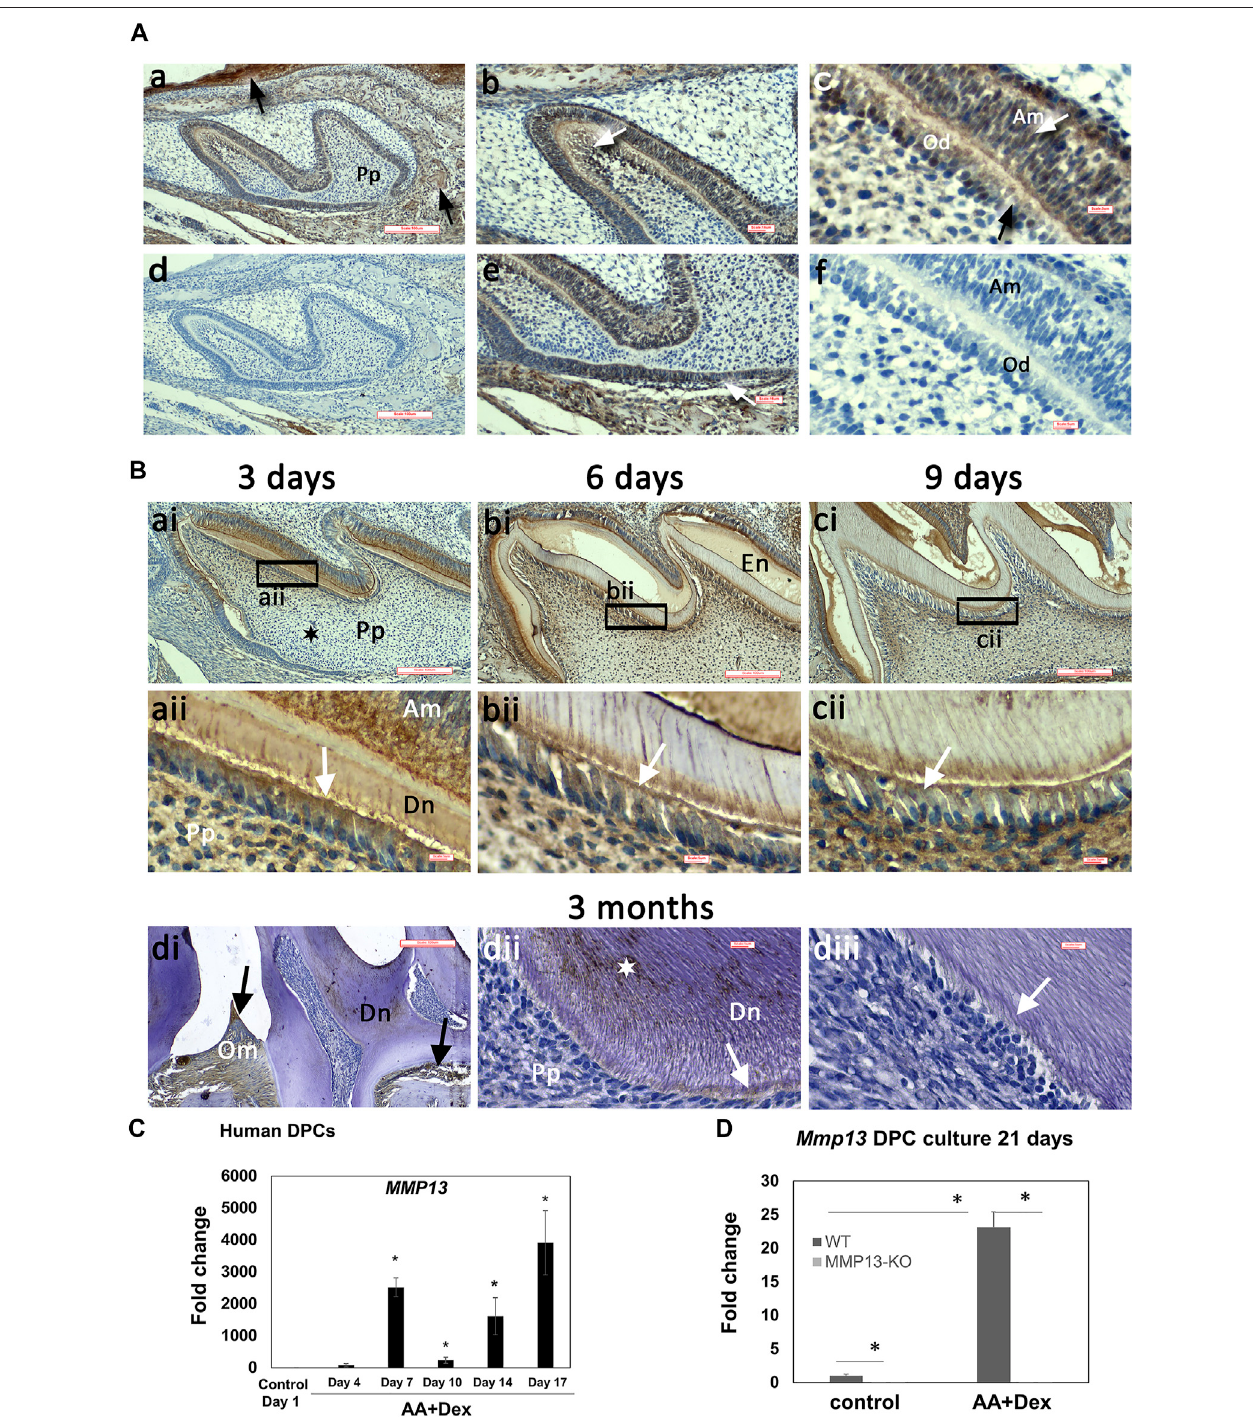
FIGURE 1 | High MMP13-expression in the dentin – pulp complex of developing mouse molars and in mineralizing human-DPC cultures. IHC analysisof MMP13 in sagittal tooth sections ofmaxillary fi rst molars (postnatal 1, 3, 6, 9-day, and 3-month). (A) Postnatal 1-d (a, b, c, e) and unstained controls (d, f) . MMP13 in oral mucosa and alveolar bone is highlighted in ( a — black arrows), in odontoblasts highlighted in ( c — black arrow), in sub-odontoblastic layer highlighted in ( b - white arrow), in ameloblastshighlightedin( c — whitearrow),androotsheathofHertwighighlightedin( e — whitearrow).Scalebars= (a,d) 100 μ m(originalmag.×10), (b,e) 16 μ m (originalmag.x20), and (c,f) 5 µm(originalmag.×63). (B) Continued high MMP13expression at postnatal 3-,6-,and 9-day (a – c) .Lowcentral pulpMMP13 expression at 3-day postnatal is highlighted (ai) by a black star. MMP13 expression in 3-month mouse molars is highlighted in the mineralized dentin ( dii — white star). Positive